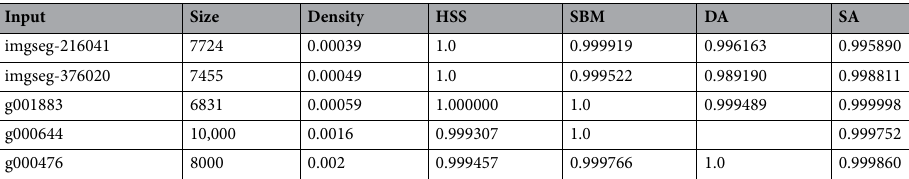
Table 7. Results for large and sparse classes, same as Table 1. For input g001883, HSS and SBM had almost the same value of the cost function, while the solution configurations were truly different from each other. The